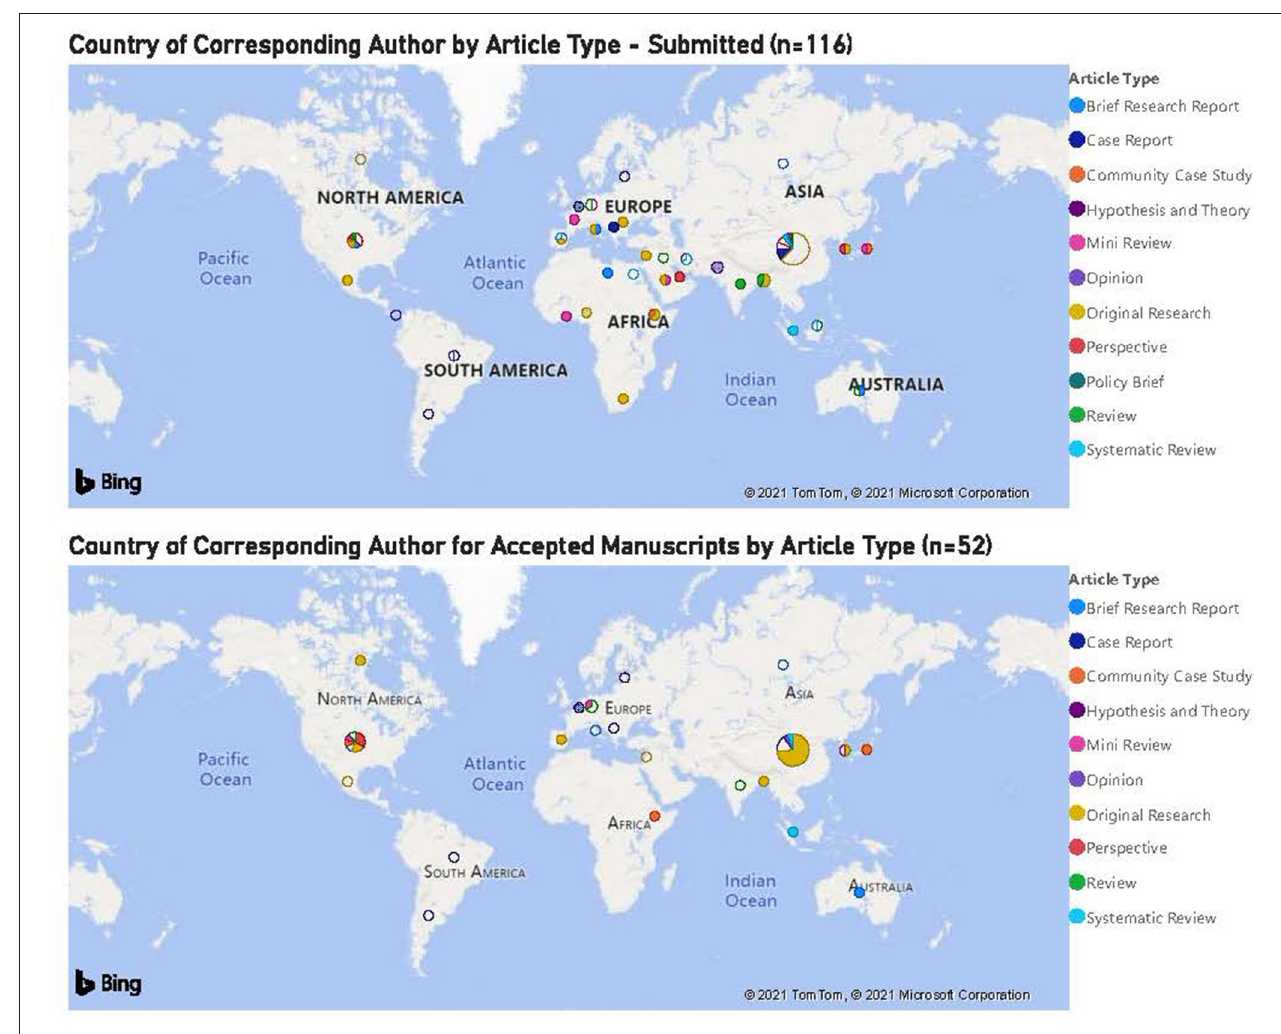
FIGURE 2 | Country of corresponding author for accepted manuscripts by article type ( n = 52). The top three country contributions were from China, USA, and